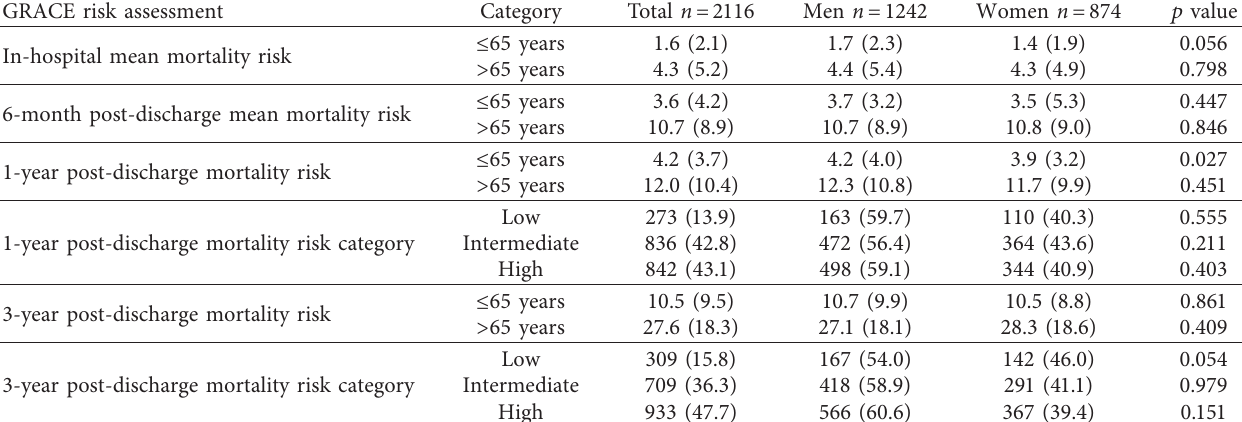
Table 2: GRACE Risk assessment of post-ACS patients stratified by sex and the risk level.